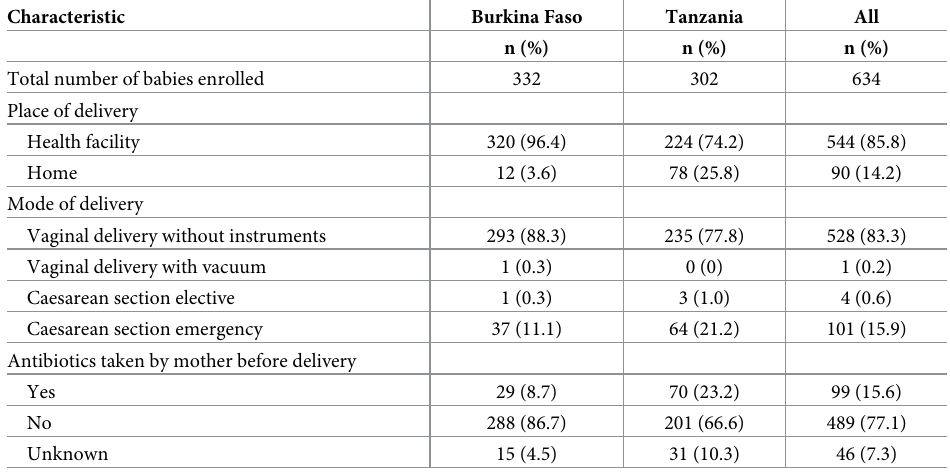
Table 2. Characteristics of mothers of young infants with clinically suspected invasive infection.